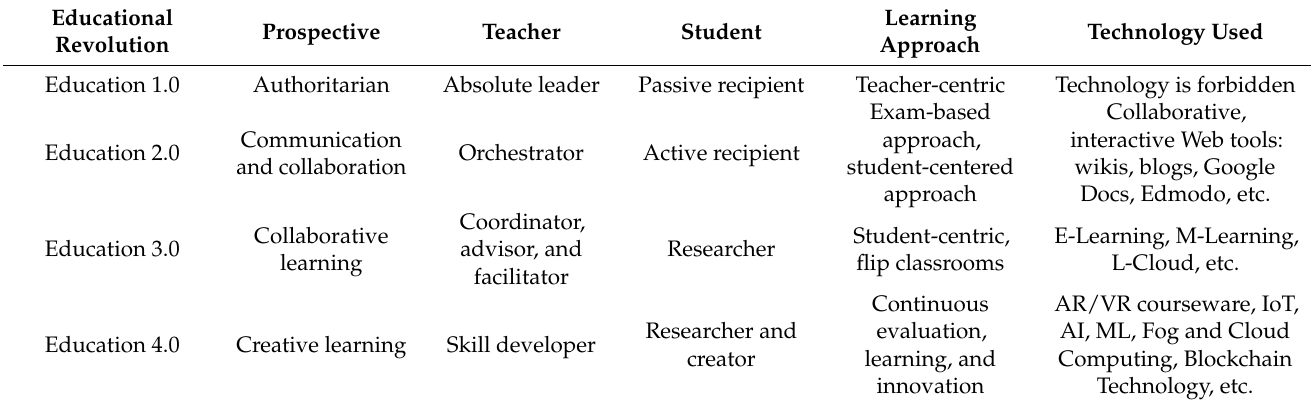
Table 1. The revolution in education from Education 1.0 to Education